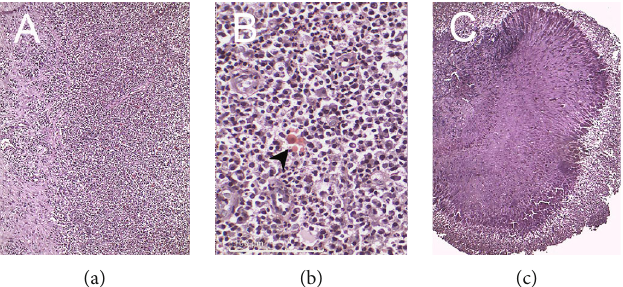
Figure 3: Pathological images: (a) granulation tissue (100 × magni fi cation); (b) showing in greater magni fi cation (400 × ) collections of plasma cells, polymorphonuclear leukocytes, a few Russell bodies (which are marked with the arrow), and areas of erythrocyte extravasation; (c) club- shaped fi laments in a radiating pattern demonstrating actinomycotic colonies (100 × magni fi cation).